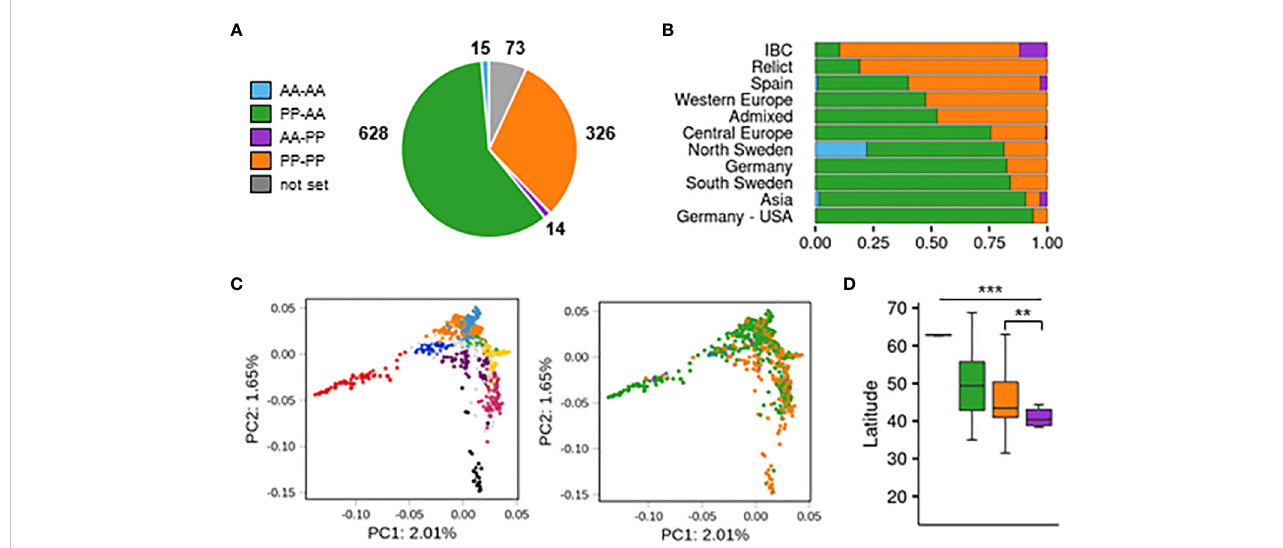
FIGURE 4 Population-scale diversity of CYP705A2 and BARS1 duplication status. (A) The sizes of four groups differing by the presence (PP)/absence (AA) of CYP705A2 - BARS1 and CYP705A2 - BARS2 gene pairs. (B) Group distribution among the genetic groups. U.S. accessions from the German group were separated from the remaining accessions. (C) Principal component analysis (PCA) plots, generated at linkage disequilibrium LD = 0.3. The fi rst two components are presented. Accessions are colored according to their genetic group (left) or CYP-BARS status (right). U.S. accessions were not included in the analysis, in order to better visualize the remaining groups. PCA plots with other LD parameters are in Supplemental Figure S17. (D) Latitudes of accessions ’ sites of origin, grouped by CYP-BARS status. One-way rank-based analysis of variance ANOVA, p value<0.001, followed by Dunn ’ s test with BH correction, ** p value<0.05 (PP-PP vs AA-PP); *** p value < 0.001 (all the other pairwise